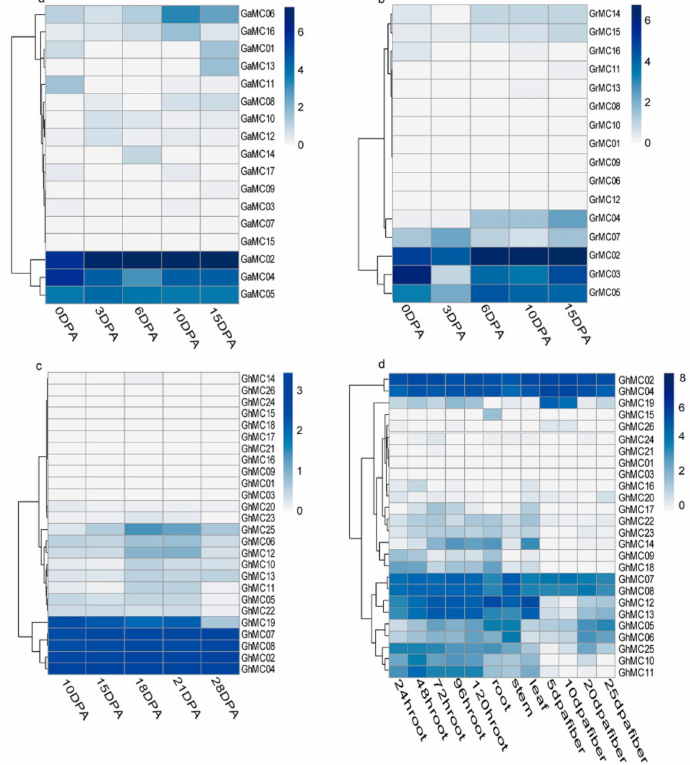
Figure 4. Heatmap presenting the metacaspase gene expression levels based on a transcriptome analysis of log 2 (FPKM + 1). ( a ) Metacaspase gene expression levels during fiber development in Gossypium arboreum (0–15 DPA). ( b ) Metacaspase gene expression levels during fiber development in Gossypium raimondii (0–15 DPA). ( c ) Metacaspase gene expression levels during fiber development in Gossypium barbadense (10–28 DPA). ( d ) Metacaspase gene expression levels during fiber development in Gossypium hirsutum (10–28 DPA). ( e ) Metacaspase gene expression levels in the root, stem, leaf, and fiber tissues from G. hirsutum